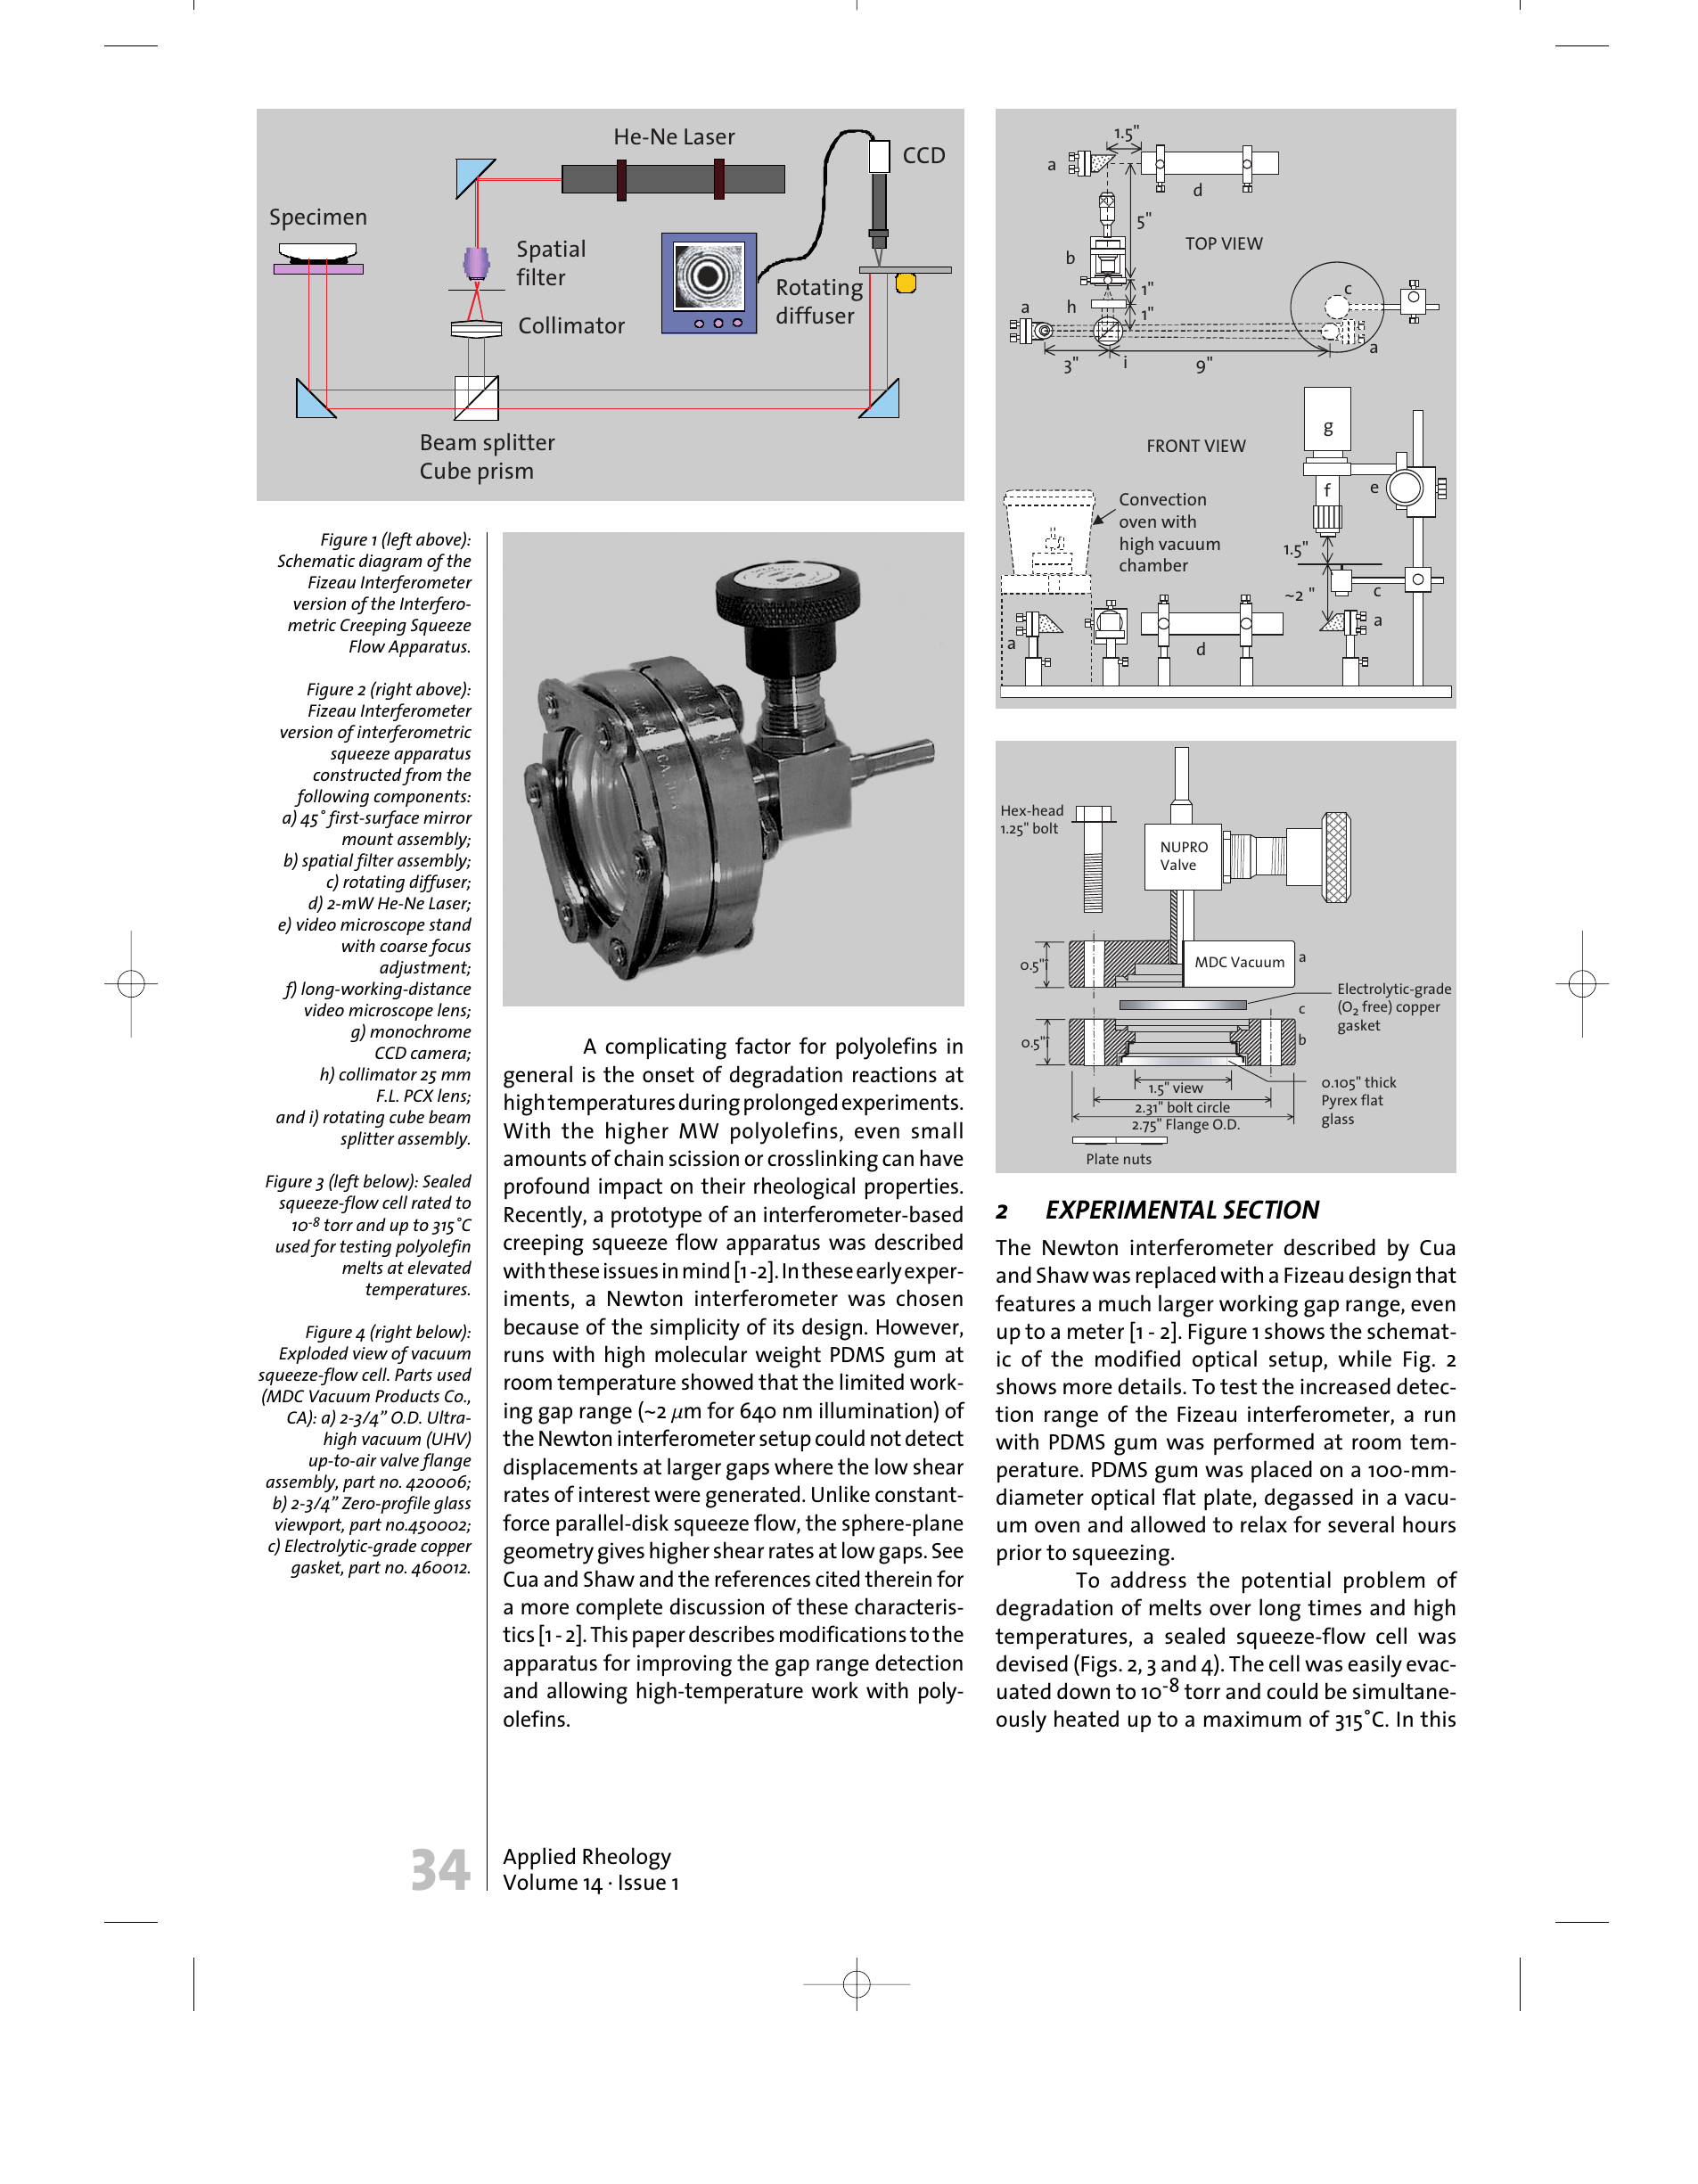
Figure 1 (left above): Schematic diagram of the Fizeau Interferometer version of the Interfero- metric Creeping Squeeze Flow Apparatus. Figure 2 (right above): Fizeau Interferometer version of interferometric squeeze apparatus